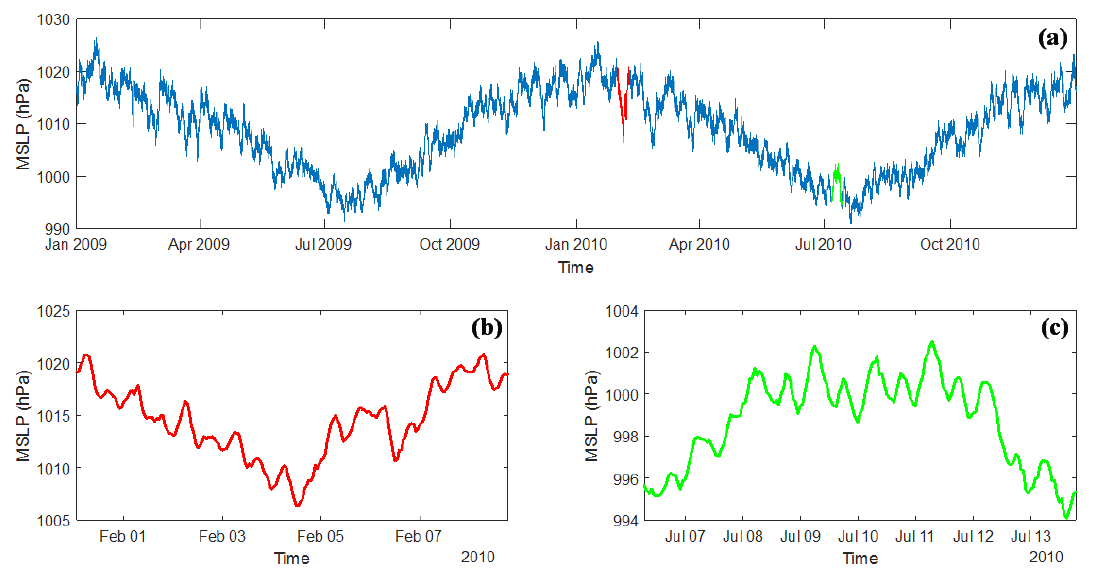
Figure 3. ( a ) Time series of mean sea ‐ level pressure at Bushehr station during 2009–2010; ( b ) an